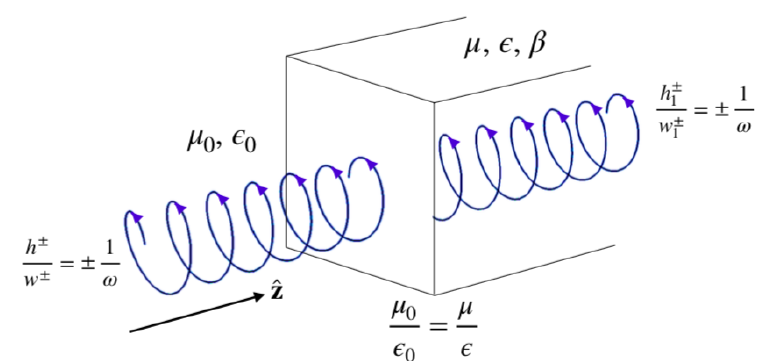
Figure 4. At the interface between a vacuum and a dual-symmetric, lossless chiral medium characterised by (cid:101) , µ and the chirality parameter β , both the energy and helicity of an electromagnetic field are conserved. As a consequence, the ratio of the helicity density to energy density, h / w , must be preserved across the interface. In the chiral medium, the energy density contains a chiral contribution, as given by w 1 (29), requiring a modification of the helicity density to h 1 (35) such that h / w = h 1 / w 1